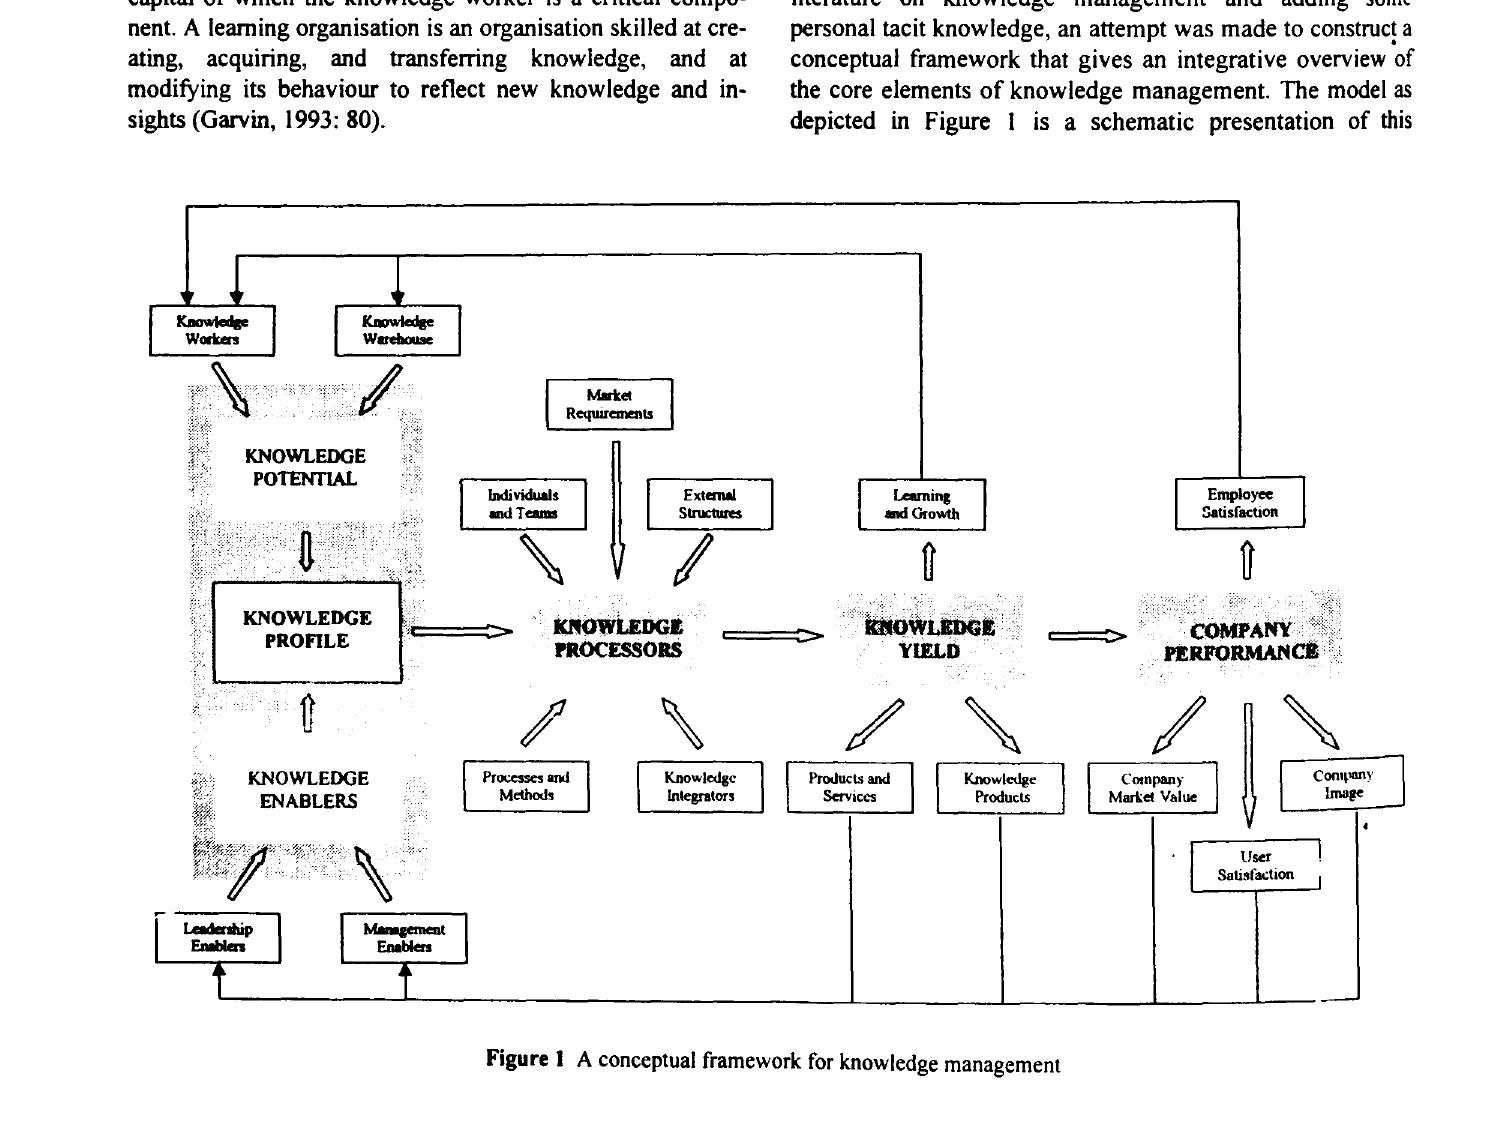
Figure 1 A conceptual framework for knowledge